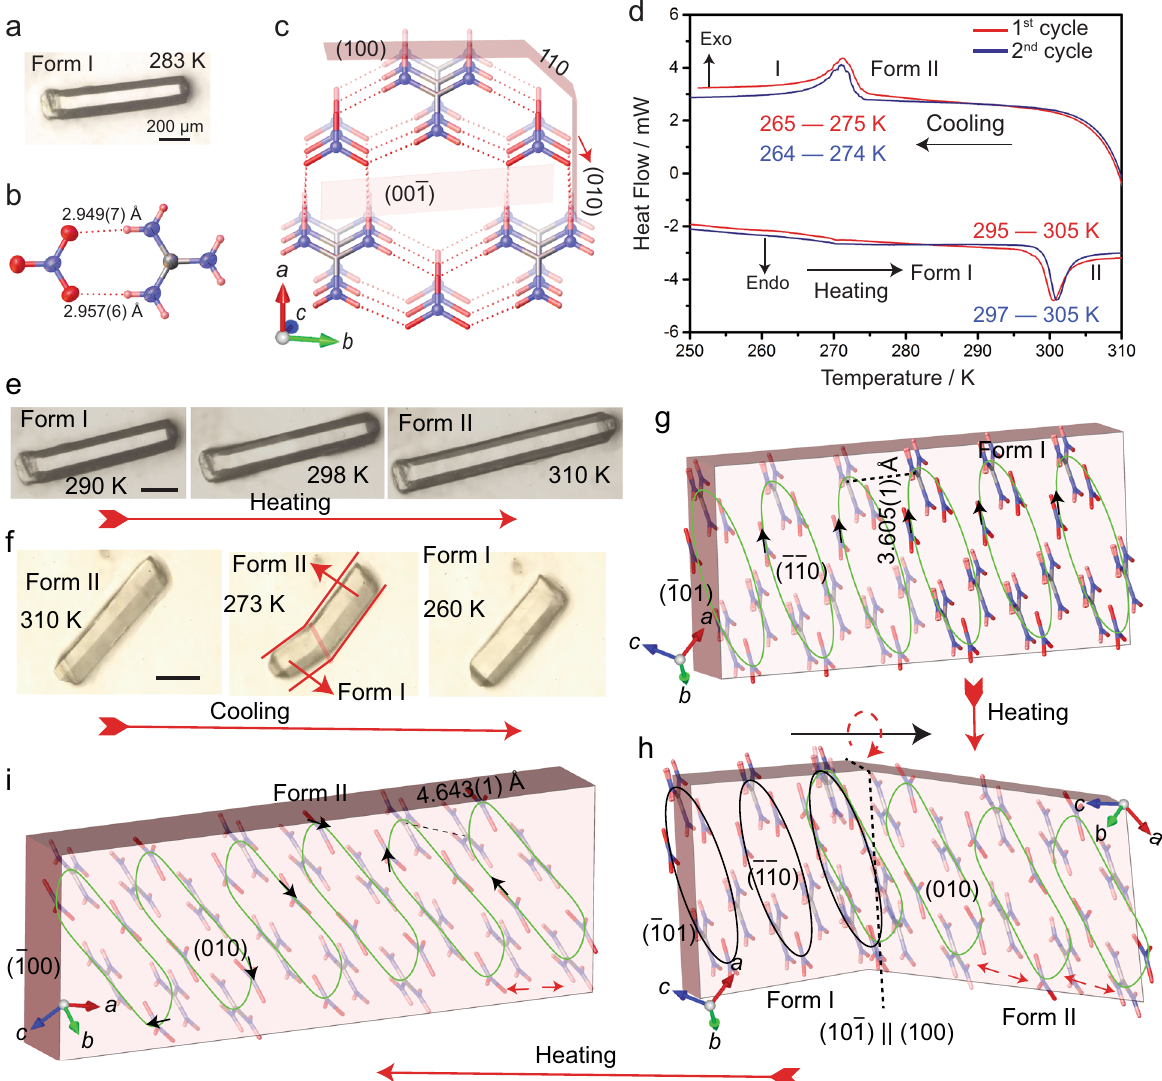
Fig. 1 Crystal habit and structure, and phase transition between forms I and II of GN. a Typical prismatic crystal habit of form I obtained by crystallization from solution. b ORTEP diagram of the main hydrogen bonding motif in the crystal structure at 250K. The thermal ellipsoids of the non-hydrogen atoms are shown at the 50% probability level. c Crystal structure of form I viewed in the [001] direction. The hydrogen bonds are shown as dotted lines. d Thermal effects accompanying the transition between forms I and II recorded by DSC (two thermal cycles are shown). Note the offset in the maximum transition temperature between the two cycles. e , f Changes in size and shape of single crystals of GN taken twice over the phase transition. Crystals converted from form I to form II by heating ( e ) and from form II to form I by cooling ( f ) between 260 and 310 K are shown. Note that the crystal does not show any visible deterioration. g , h , i Crystal packing comparison of the form I ( g ), partially converted crystal ( h ) form II ( i ) and analyzed by single crystal X-ray diffraction. Scale bars: e 300 µ m, f 200 µ